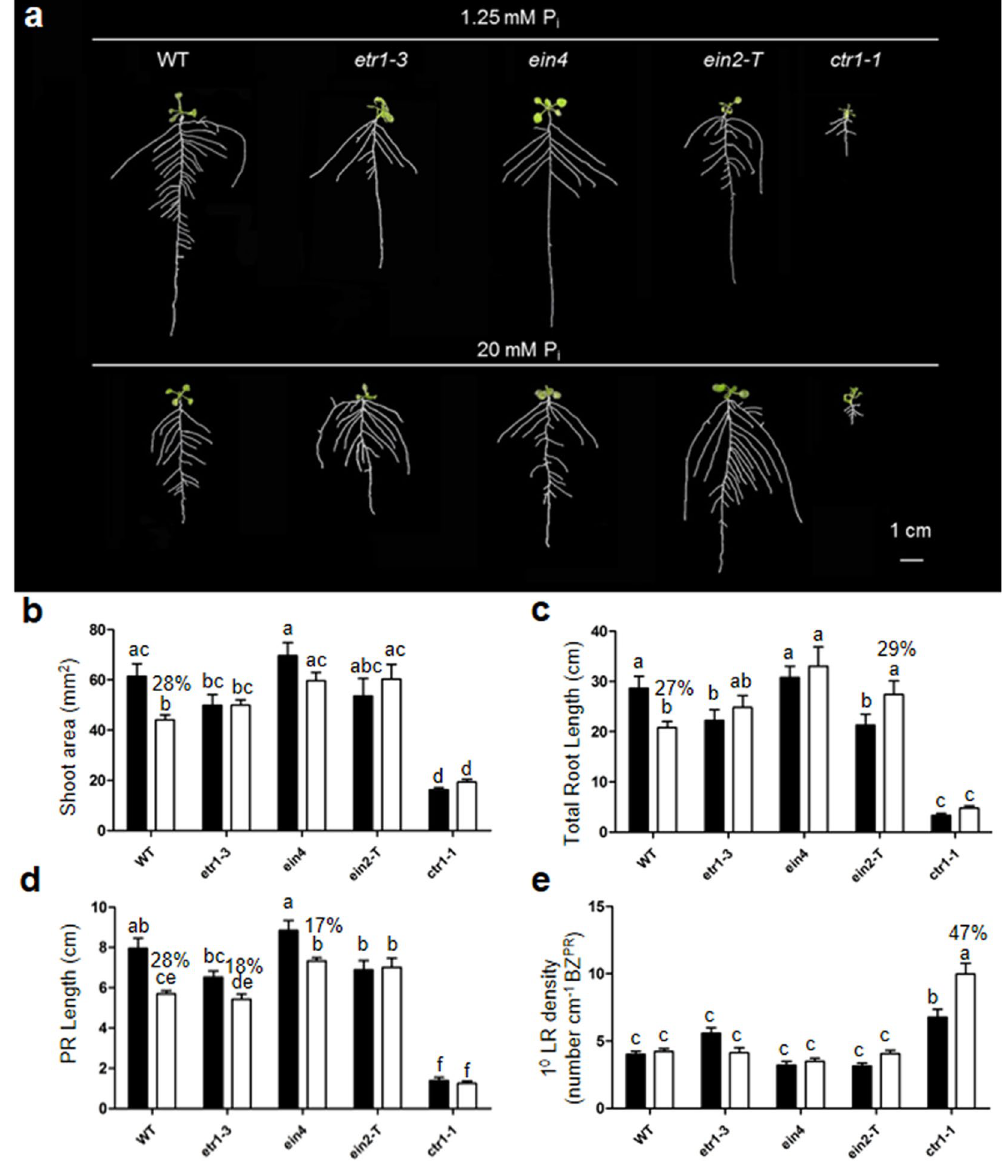
Figure 8. Root system architecture of wild type, ethylene-insensitive mutants ( etr1–3 , ein4 , ein2-T ) and sensitive mutants ( ctr1–1 ) under 1.25 mM P i and 20 mM P i . Wild-type (WT) and ethylene mutants were grown as described in the caption to Fig. 1. Individual seedlings were spread as described in the caption to Fig. 3 for documentation of different traits ( b–e ). Data are presented for shoot area ( b ), total root length ( c ), primary root length ( d ), and 1° lateral root density ( e ). Black and white bar represent treatments 1.25 mM and 20 mM, respectively. Values are means ± SE n = 15. Mean bars with different alpha letter differ significantly (P ≤ 0.05– 0.001) according to two-way ANOVA with Bonferroni correction posttest